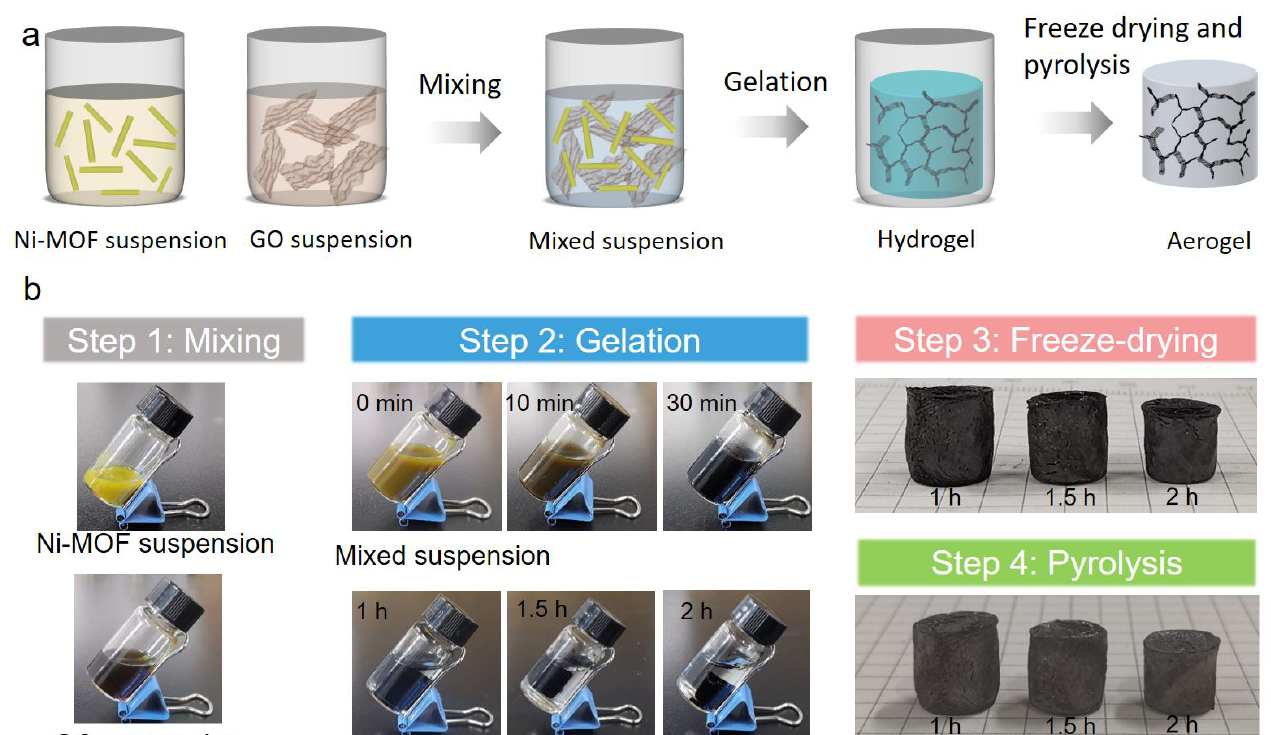
Figure 2. ( a ) Schematic diagram and ( b ) the pictures at each step of the synthetic process for Ni 3 S 2 @N, S-codoped graphene aerogels.